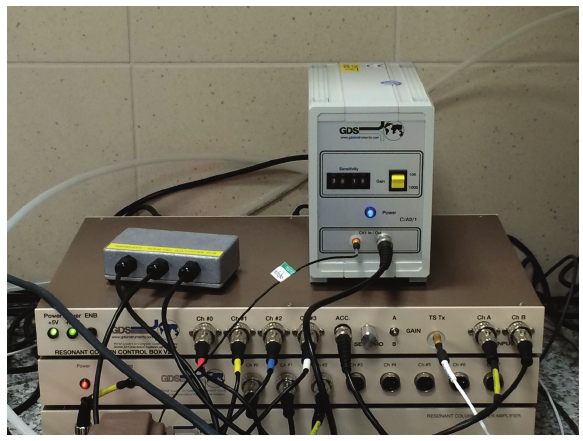
Fig. 3. GDS RCA Control Box v2